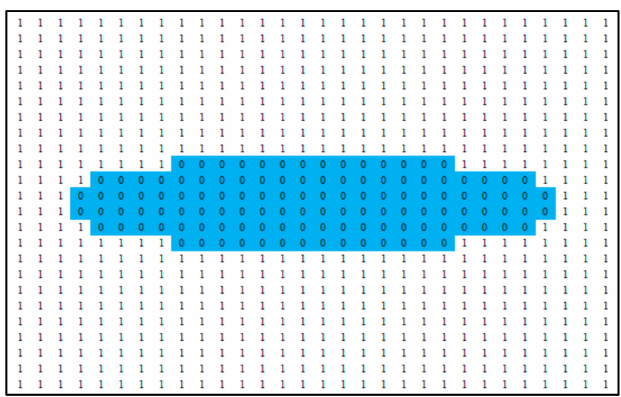
Figure 12. Partial 0–1 distance field.